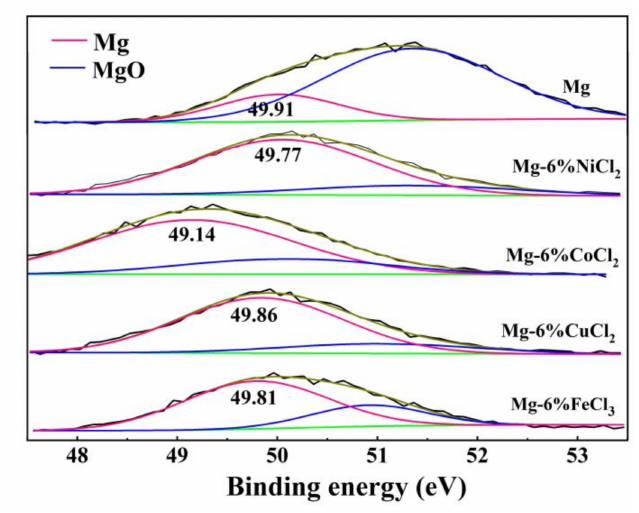
Figure 4. XPS spectra of the ball-milled